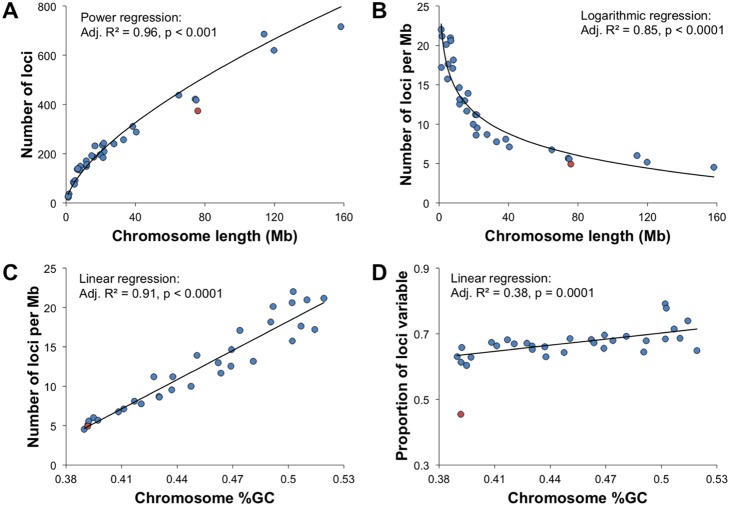
Genomic distribution of indigobird ddRAD loci based on BLAST results against the zebra finch reference genome.Includes 7,819 loci that had one or a “best” BLAST hit and were genotyped in at least 42 of 46 samples (n = 5,045 variable loci, n = 2,774 constant loci). Data for the “chrUn” contig and small contigs with no BLAST hits (e.g., “chr16”, “LG2”, “LG5”) are excluded. (A) The number of loci mapped to each chromosome as a function of chromosome length. (B) The density of loci as a function of chromosome length. (C) The density of loci as a function of chromosome GC content. (D) The proportion of loci that was variable as a function of chromosome GC content. The Z-chromosome is indicated by a red point in each panel and was not used in regression analyses.